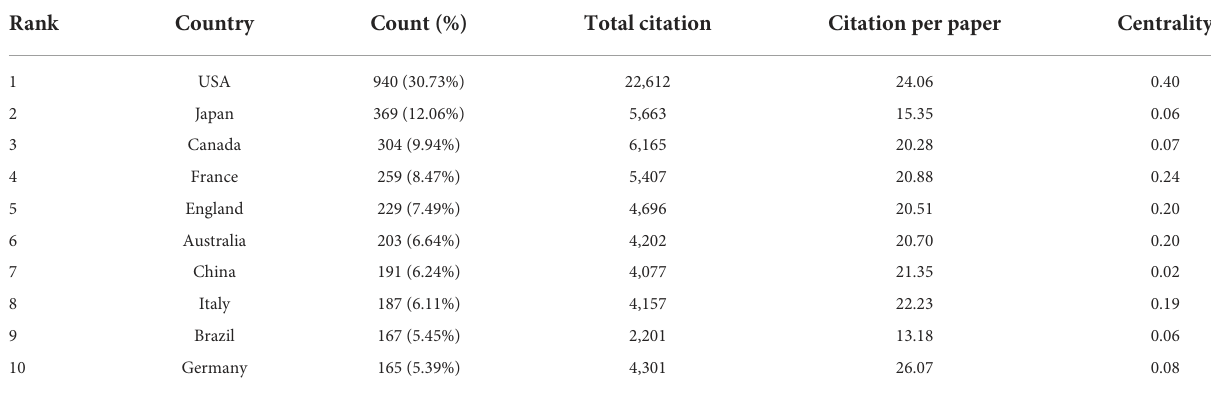
TABLE 2 The top 10 productive countries/regions from 2011 to